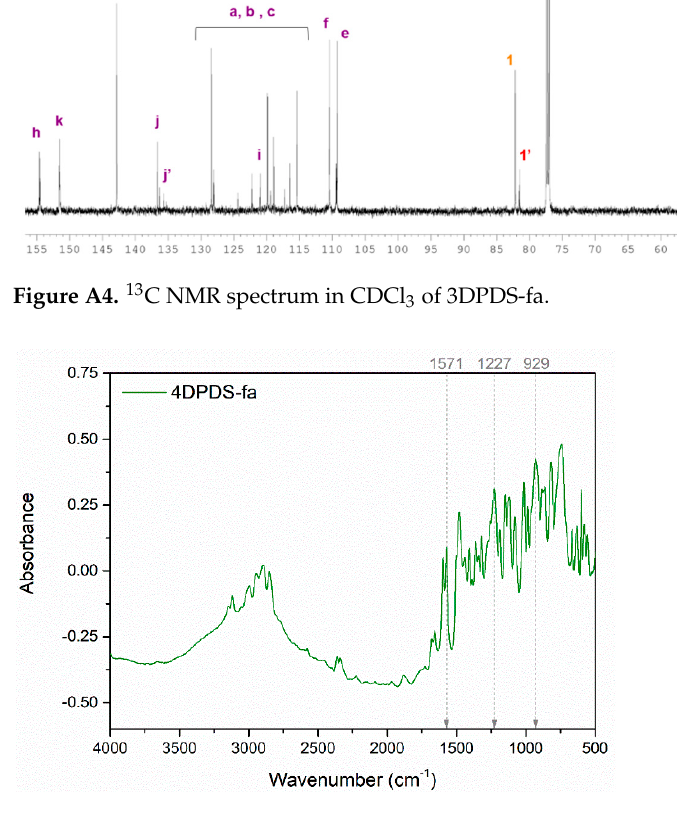
Figure A5. FTIR spectrum of 4DPDS-fa.